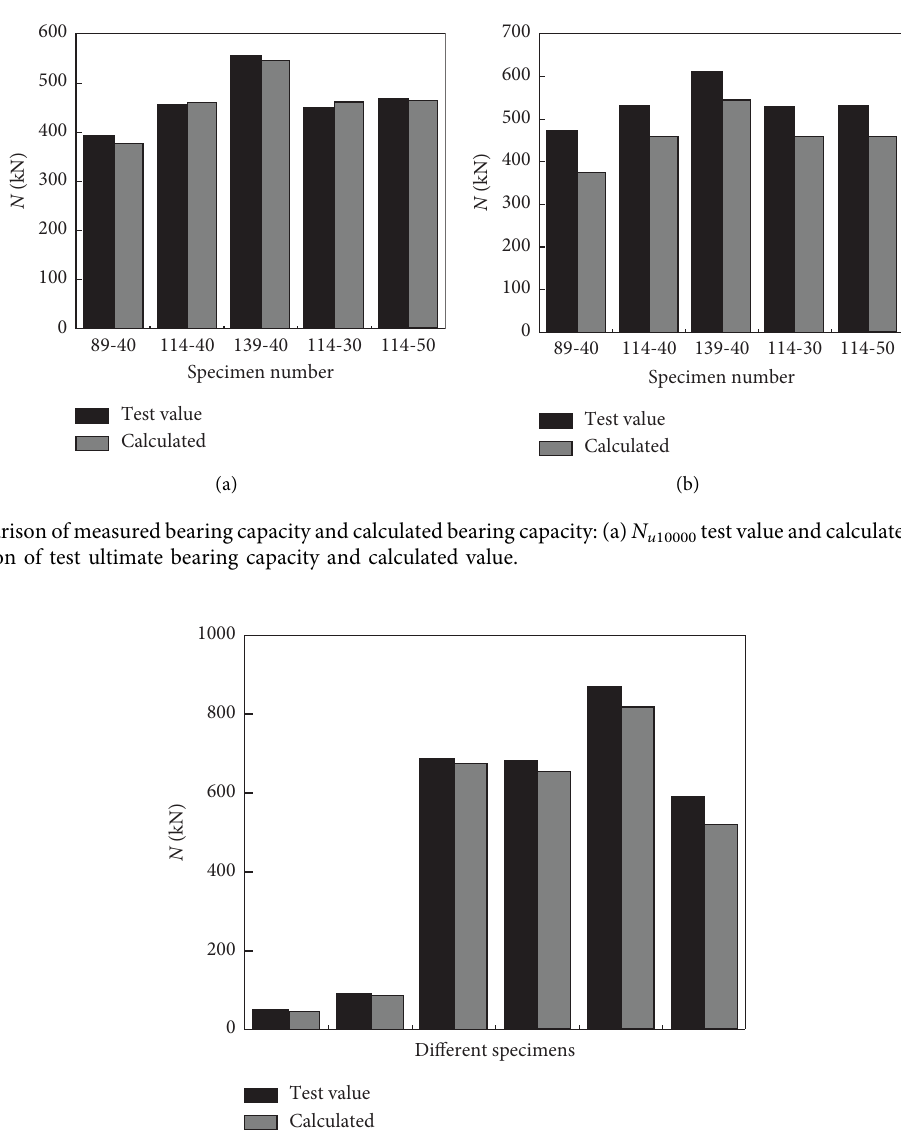
Figure 23: Comparison of the measured bearing capacity of the specimen in the literature and the calculated value of the